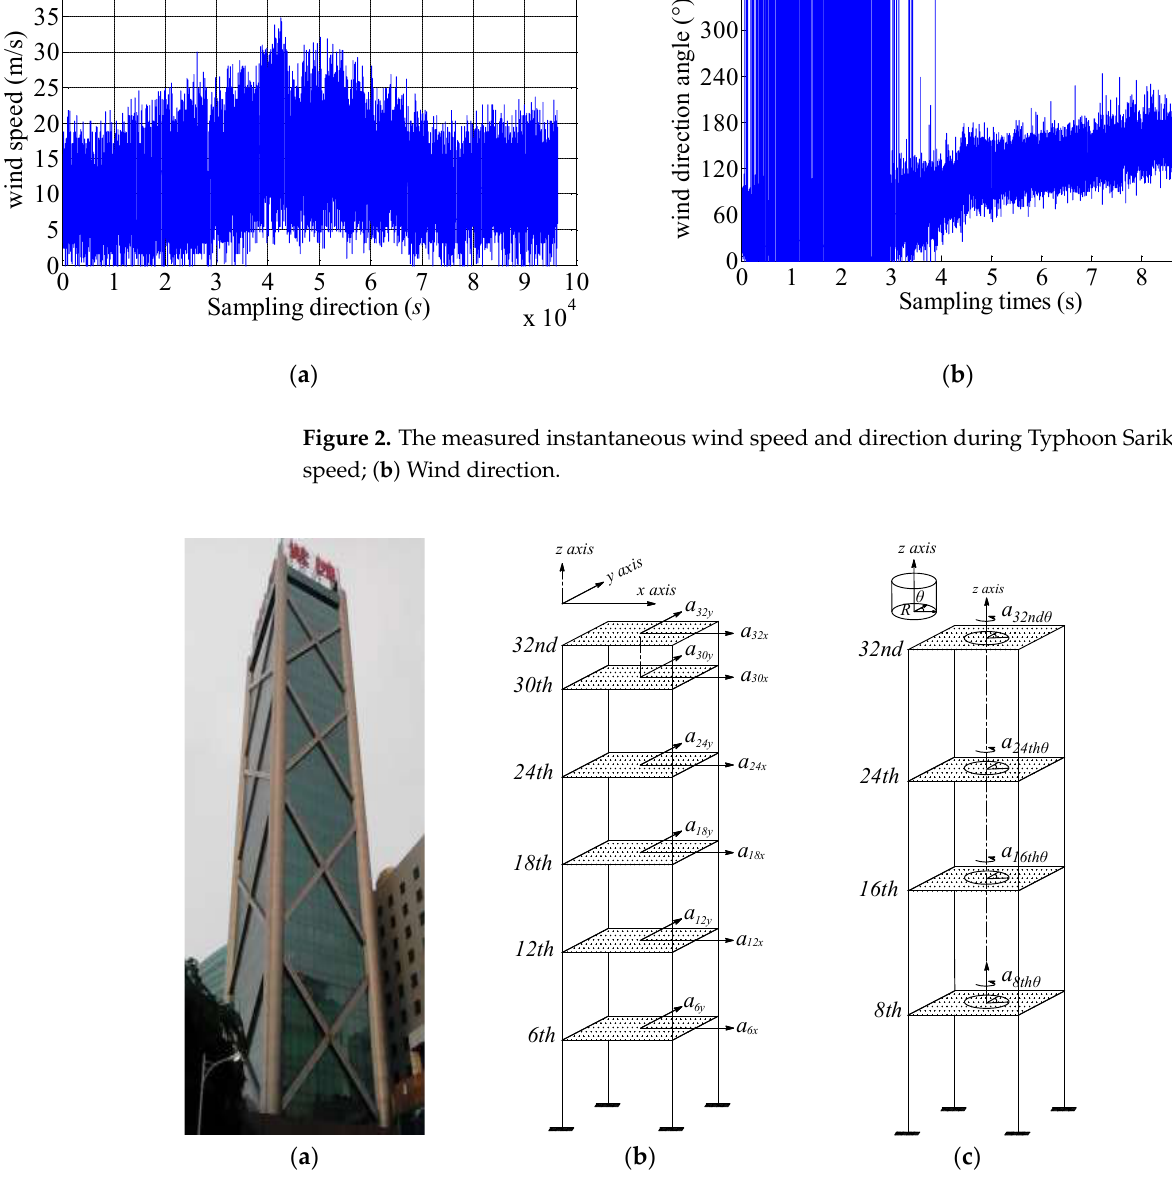
Figure 3. Overview of the measured building, translational and torsional measured points. ( a ) The measured building; ( b )Translational measured points; ( c ) Torsional measured points.